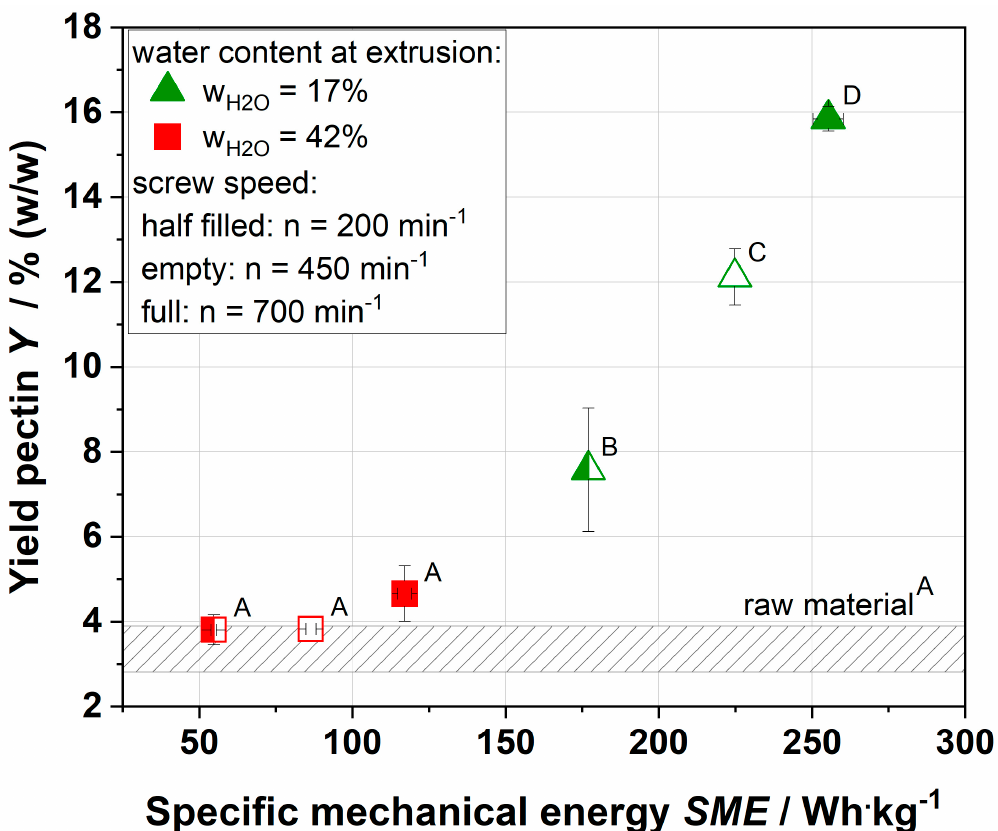
Figure 1. Dependency of specific mechanical energy (SME) and yield of water-soluble pectin extracted by ethanol precipitation (pectin yield) in weight percentage for raw apple pomace and extruded pomace. The apple pomace was extruded at water contents of 17 (triangular) and 42% (square), and 200 (half-filled), 450 (empty), and 700 (full) min − 1 . Di ff erent symbols were chosen to uniquely identify samples and their process conditions in the following figures. A–D Mean values within a row that are marked with di ff erent letters di ff er significantly ( p <